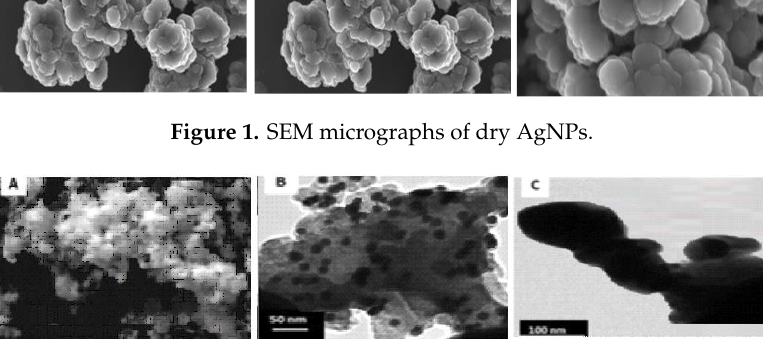
Figure 2. TEM micrograph of AgNPs in suspension at a working distance of ( a ) 10 nm ( b ) 50 nm ( c ) 100